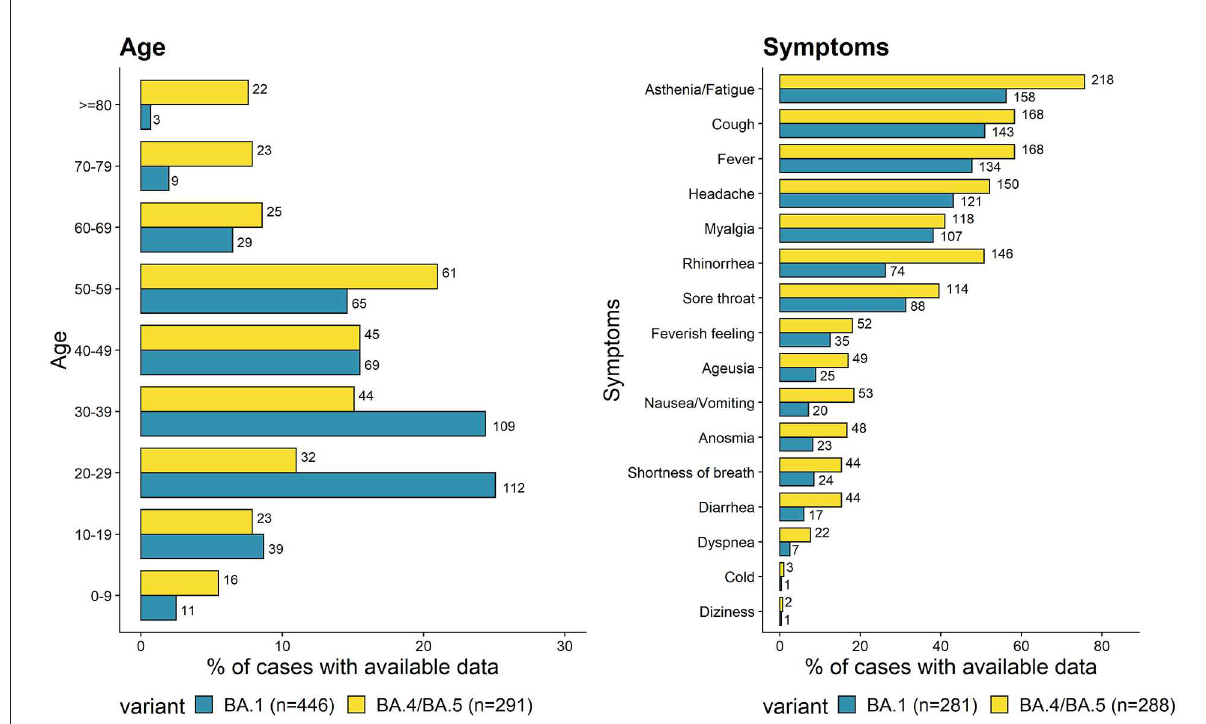
FIGURE1 Proportion of age groups (left panel) and symptoms (right panel) of BA.4/BA.5 cases compared to previously investigated BA.1 cases. Absolute numbers of cases are shown beside the bars.